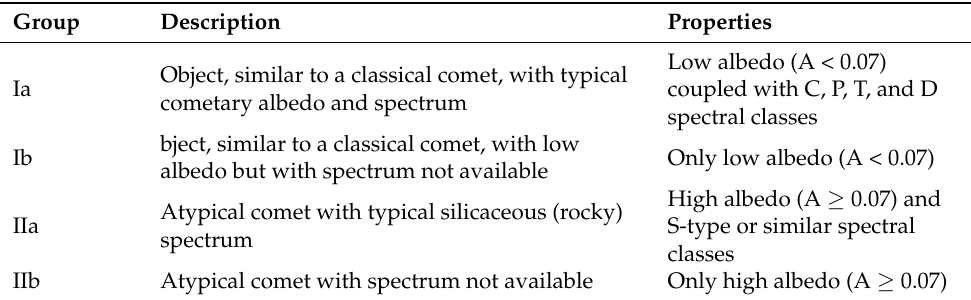
Table 3. Classification of active objects by ice sublimation with asteroidal orbits (T J > 3) based on their albedo and their spectral